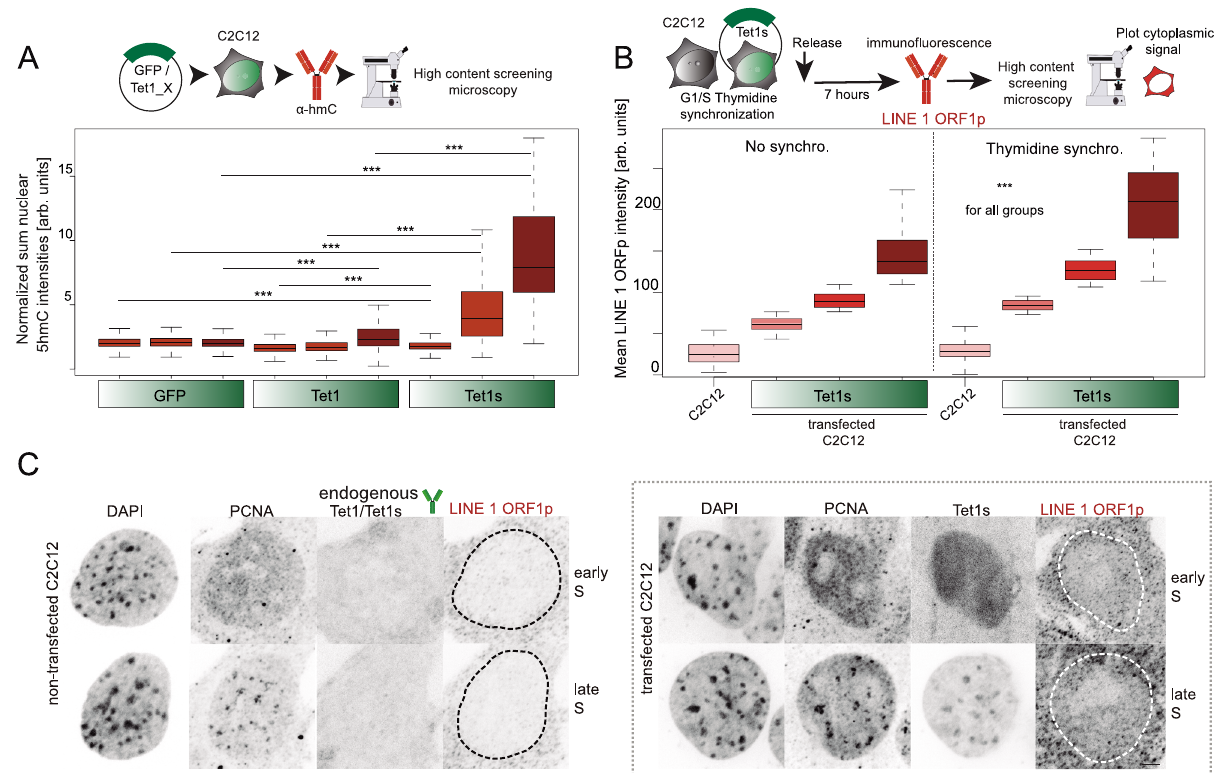
Fig. 3 | C2C12 cells overexpressing Tet1s show aberrant 5mC oxidation and higher levels of LINE 1 ORF1p. A Cells transfected with EGFP-Tet1, EGFP-Tet1s or EGFP alone, were immunostained against 5hmC. Fluorescence intensity levels of overexpressed proteins and 5hmC were measured, sum nuclear 5hmC levels were normalized to the sum nuclear DAPI intensity and grouped as described in Sup- plementaryFig.2B,D. B C2C12cellsnon-transfectedandtransfectedwithGFP-Tet1s were synchronized and immunostained against LINE 1 ORF1 protein. Fluorescence intensity levels of the protein were measured and mean cytoplasmic levels were plotted. Representative confocal images for LINE 1 ORF1p and TET1/TET1s